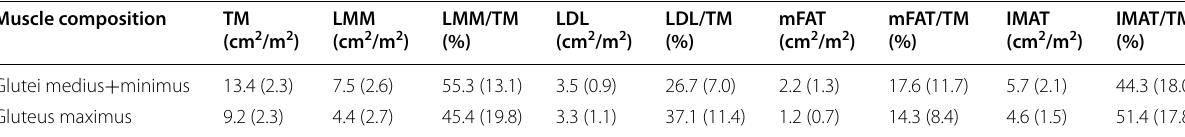
Table 1 Preoperative muscle composition